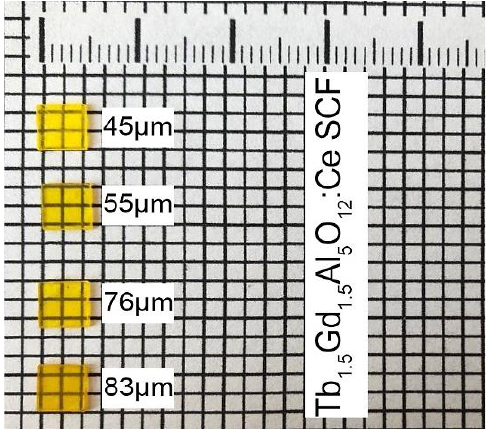
Figure 1. LPE grown TbGdAG:Ce SCFs/YAG epitaxial structures with different SCF thicknesses.